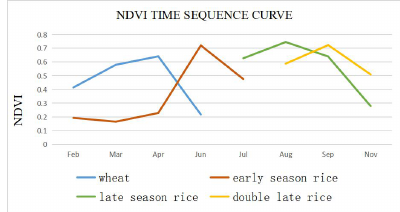
Figure 6. NDVI time sequence curve of grains in Zhejiang The best observation period is decided by the maximum value of NDVI curve which means the target crop has the most